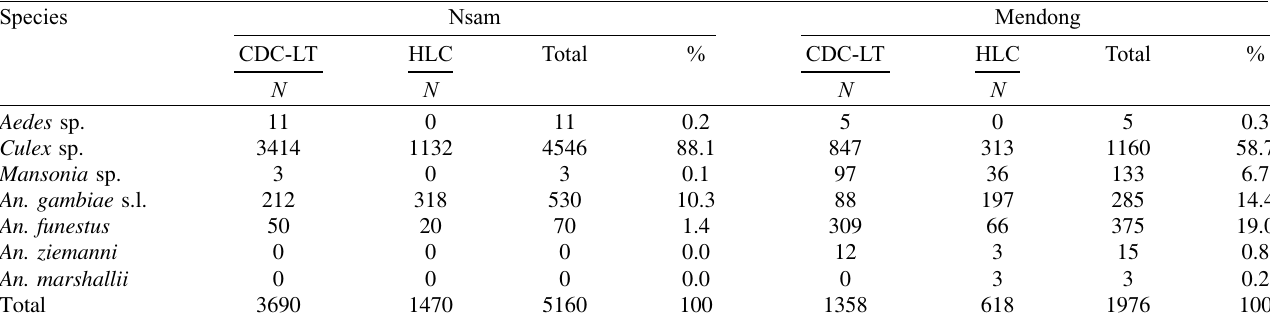
Table 4. Monthly variation of the composition of species in the An. gambiae complex and An. funestus group in Nsam and Mendong.